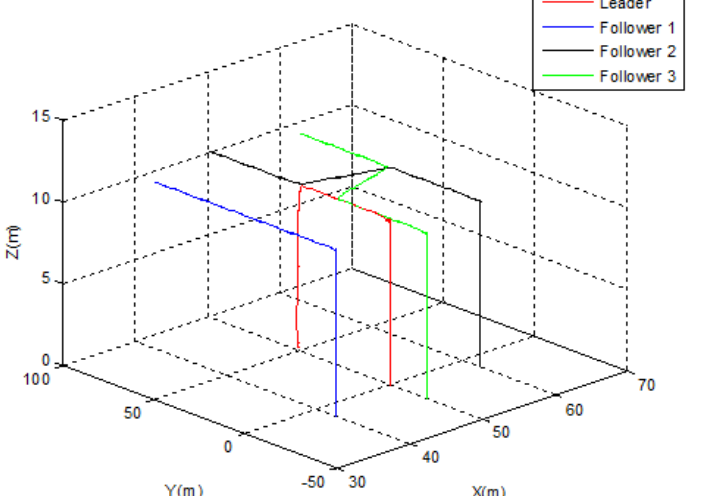
Figure 9. Leader election Case 2.